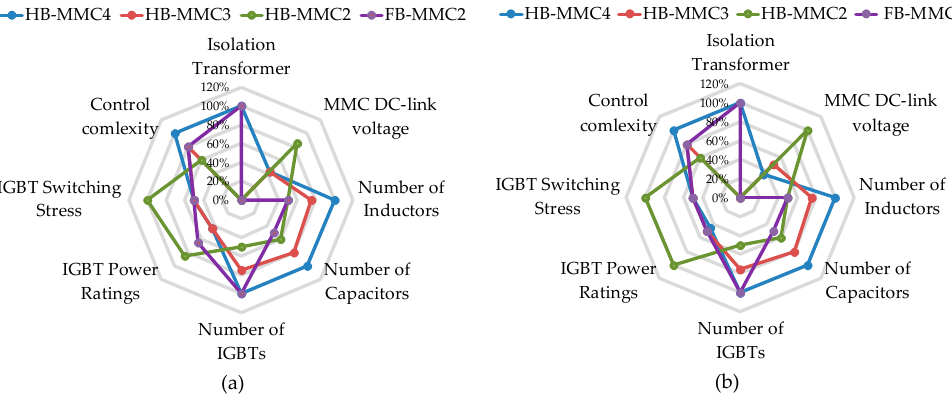
Figure 23. Comparison between the multilevel RPC topologies, using radar charts: ( a ) in the V/V power transformer; and ( b ) in the Scott power transformer (based on [6–8,10,33]).